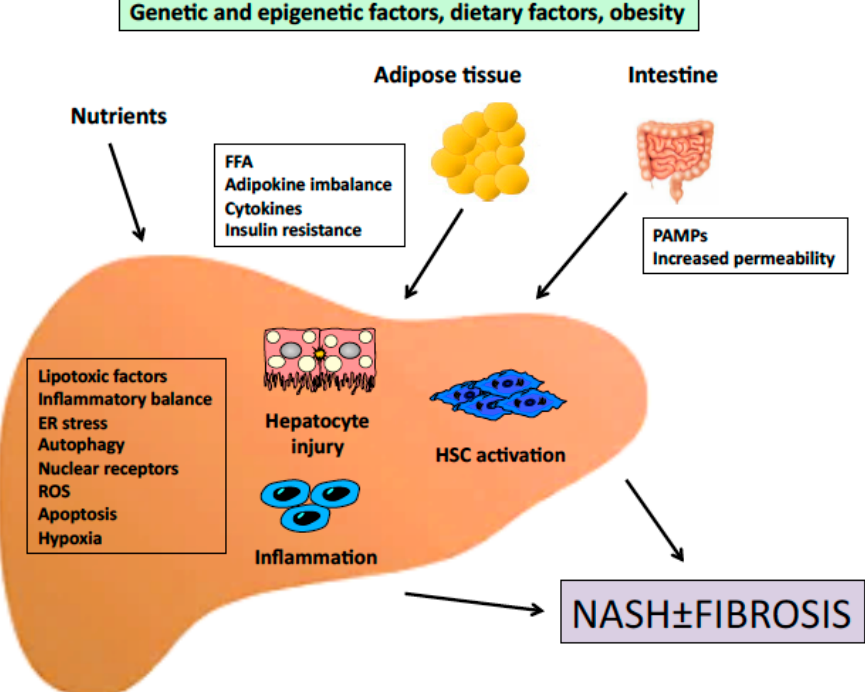
Figure 1. Outline of the pathogenesis of NASH. Signals generated inside the liver as a consequence of increased lipid accumulation, together with signals derived from extrahepatic organs cooperate to induce inflammation and fibrosis. FFA, free fatty acids; PAMPs, pathogen-associated molecular patterns; ER, endoplasmic reticulum; ROS, reactive oxygen species; HSC, hepatic stellate cell.